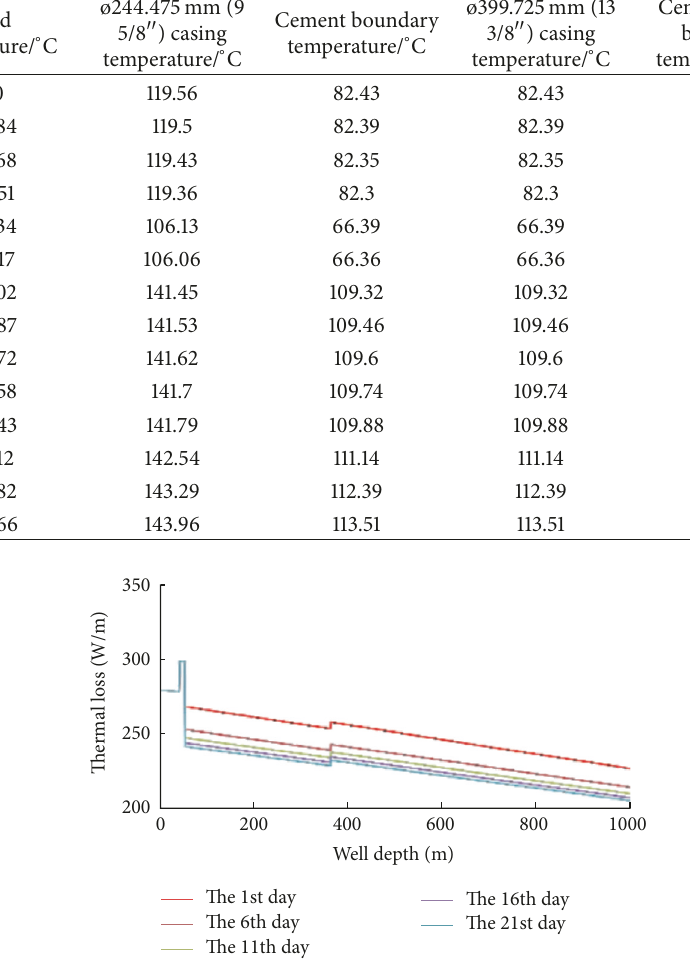
Figure 3: Thermal loss along